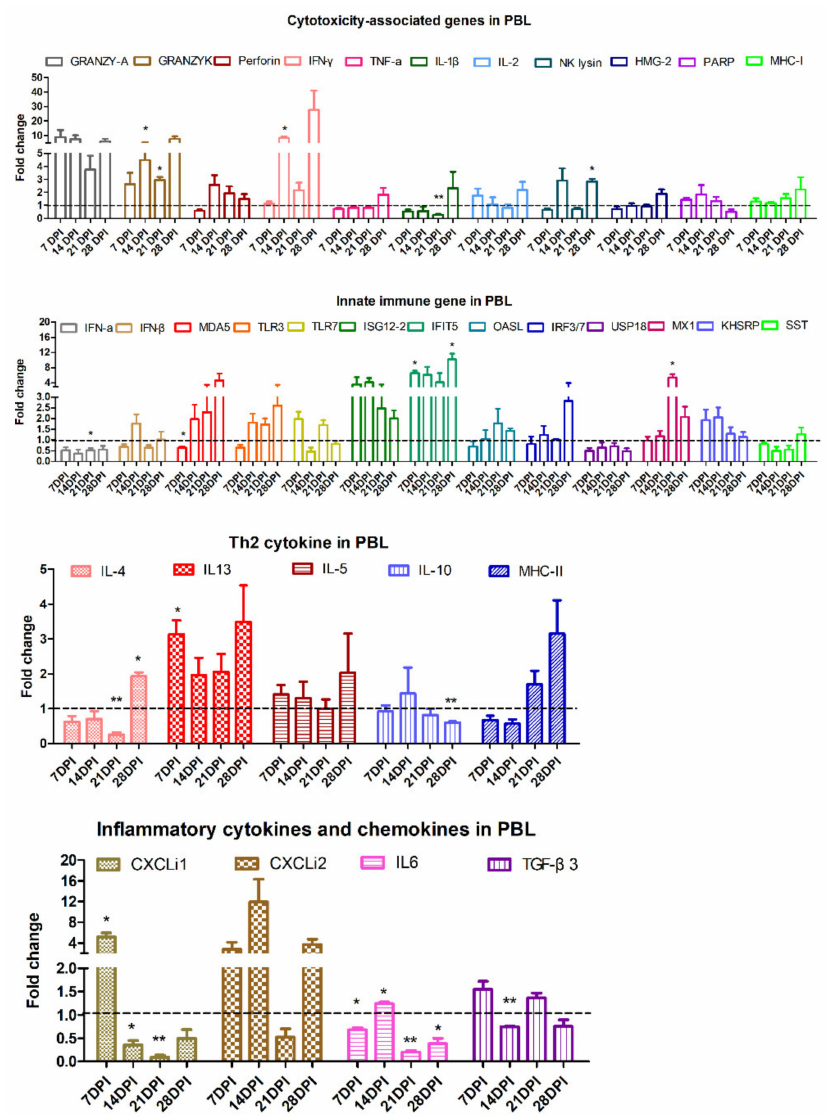
Figure 5. Analysis expression of immune-related genes in PBL by qRT-PCR. Expressions of immune-related genes in PBL were detected by qRT-PCR. The total RNA of PBL was extracted from three chickens of the infected and control groups, respectively. The data was collected from three biological samples in each group, each sample performed in triplicate. The results were presented as means ± SEM and the paired t -test was used for statistical comparison. ns p > 0.05, * p < 0.05, ** p <